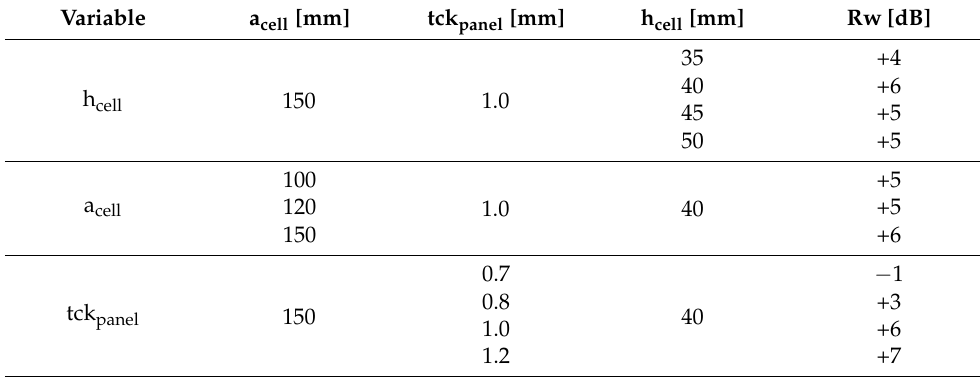
Table 2. Values chosen for primitive unit cell characteristic dimensions (with reference to Figure 4b) used for the optimization process, with corresponding